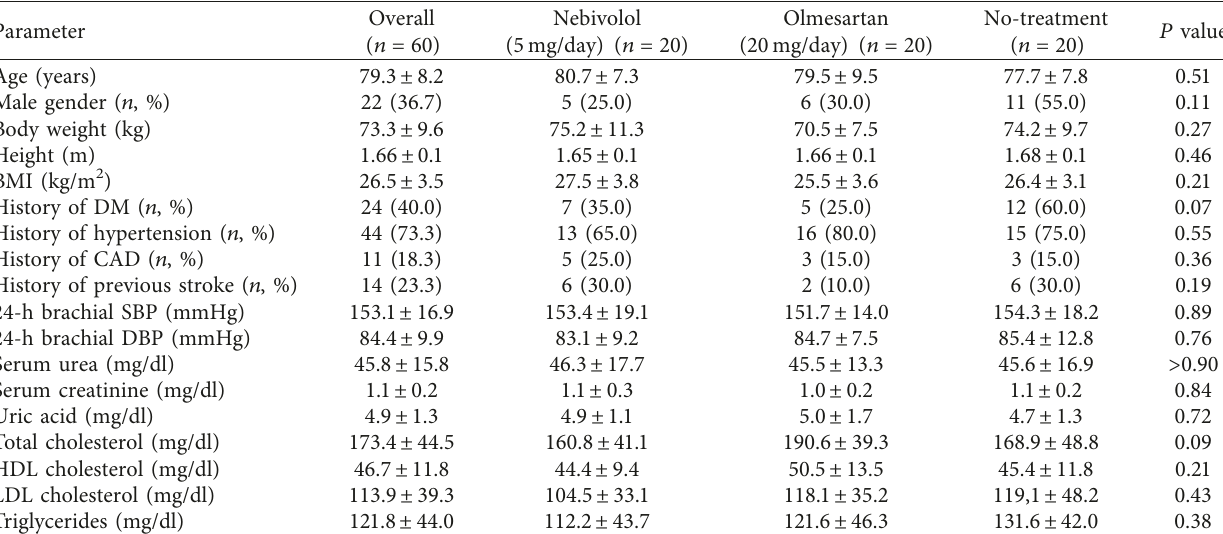
Figure 1: Flow diagram of patient enrollment. Table 1: Baseline, demographic, clinical, and laboratory characteristics of study